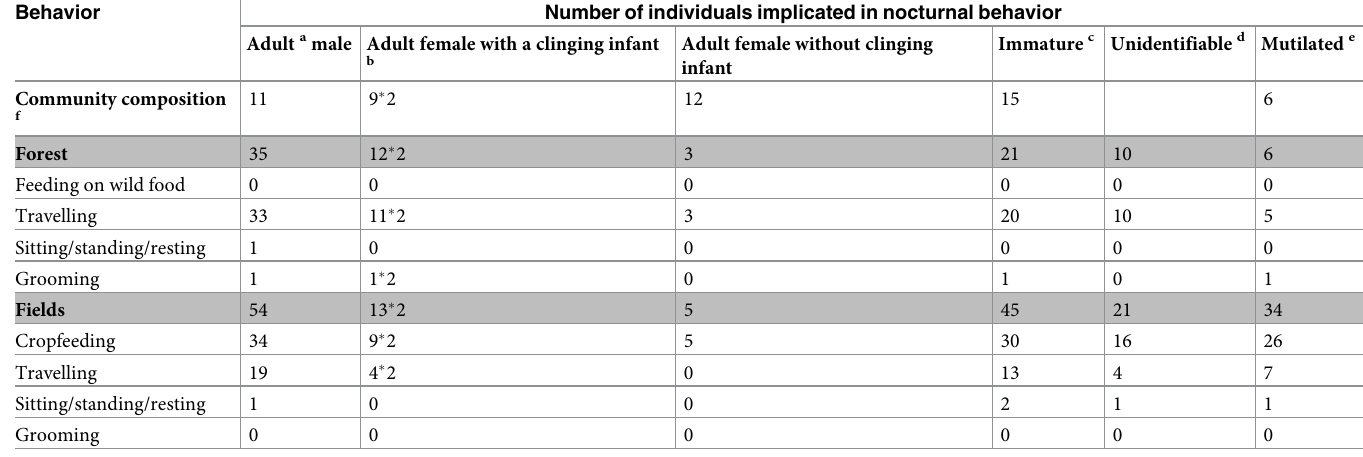
Table 2. Frequency of occurrence of chimpanzee nocturnal activity in function age-class and sex.